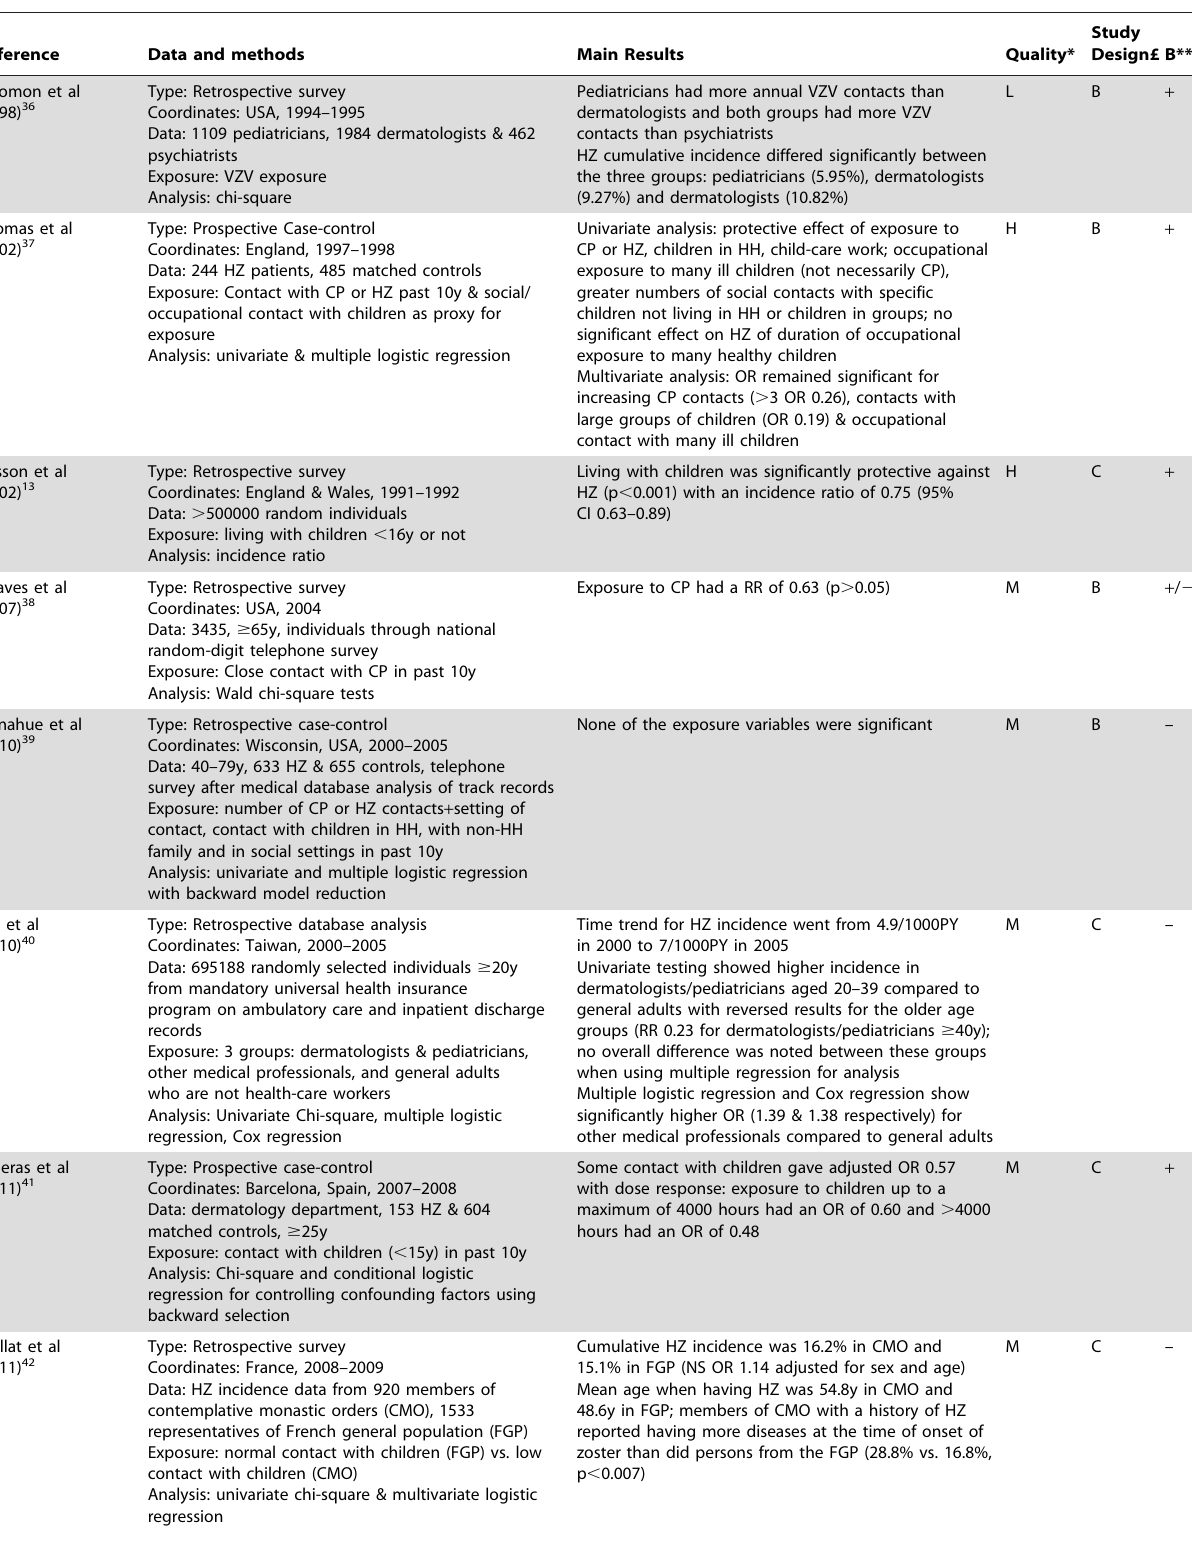
Table 3. Description of selected epidemiological risk factor